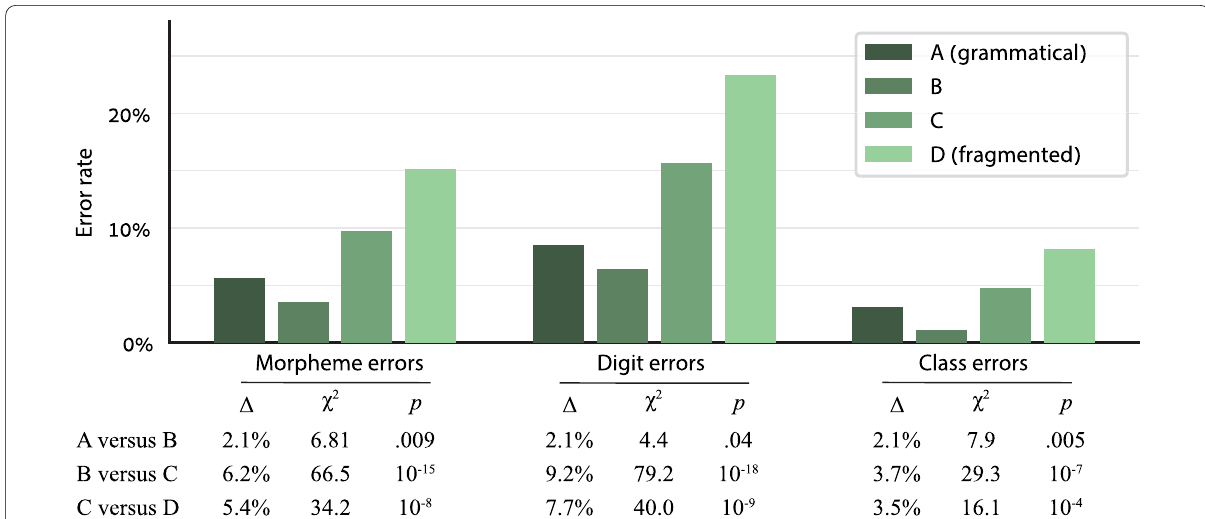
Fig. 2 Experiment 1 results: the morpheme, digit, and class error rate in each condition. The best performance was in condition B. In this condition, each stimulus included 2 grammatical segments with 3–4 words in each; this seems to provide the optimal balance between the number of chunks and the chunk size. The performance was poorer in conditions C and D, which seem to support too little chunking as the stimuli have short grammatical segments; and in condition A, which seems to encourage too much chunking as the stimulus has a single long grammatical segment. This clear syntactic chunking effect shows that the participants represented the number’s syntactic structure. In the statistics table, Δ, χ 2 , and p refer to the effect size and significance of the Condition factor in the linear mixed model described in the “Statistical analysis” section